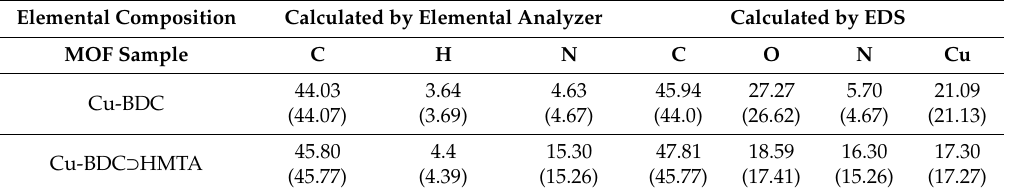
Table 1. Elemental composition of Cu-BDC and Cu-BDC ⊃ HMTA.